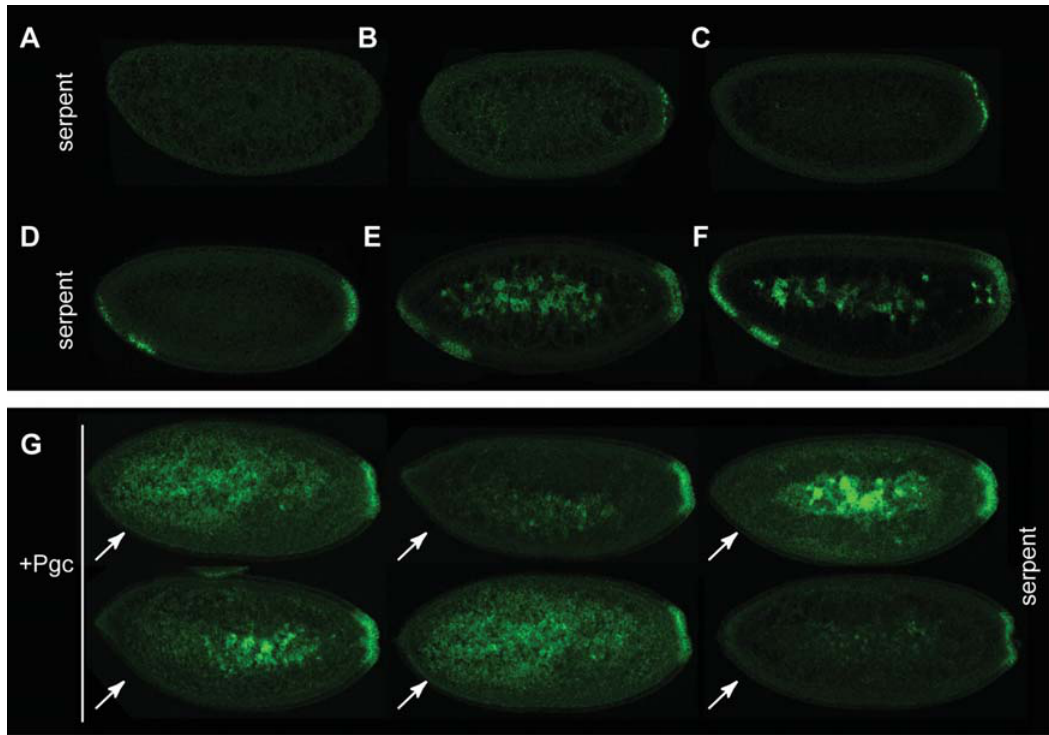
Figure 5. Suppression of a later zygotic transcript in Drosophila somatic nuclei by the Pgc oligopeptide. Fluorescent in situ hybridization with an RNA probe detecting serpent mRNA. There is no detectable maternal supply of serpent mRNA ( A ). serpent mRNA is first detectable at the posterior end during cleavage cycle 11 ( B ). The amount of serpent mRNA increases further until cellularization in the posterior somatic nuclei without detectable expression in the anterior nuclei ( C ). Upon cellularization, serpent mRNA is detected in two anterior areas: in cells in the anterior pole and in an antero-ventral cell group ( D ). As cellularization progresses, the cells become columnar, and serpent mRNA signals further increase in the anterior cell groups ( E , F ). ( G ) Representative images of cellularizing embryos that have been injected with purified Pgc in the anterior region (arrows). Pgc injection suppresses serpent mRNA accumulation in the anterior region (compare with D – F ).